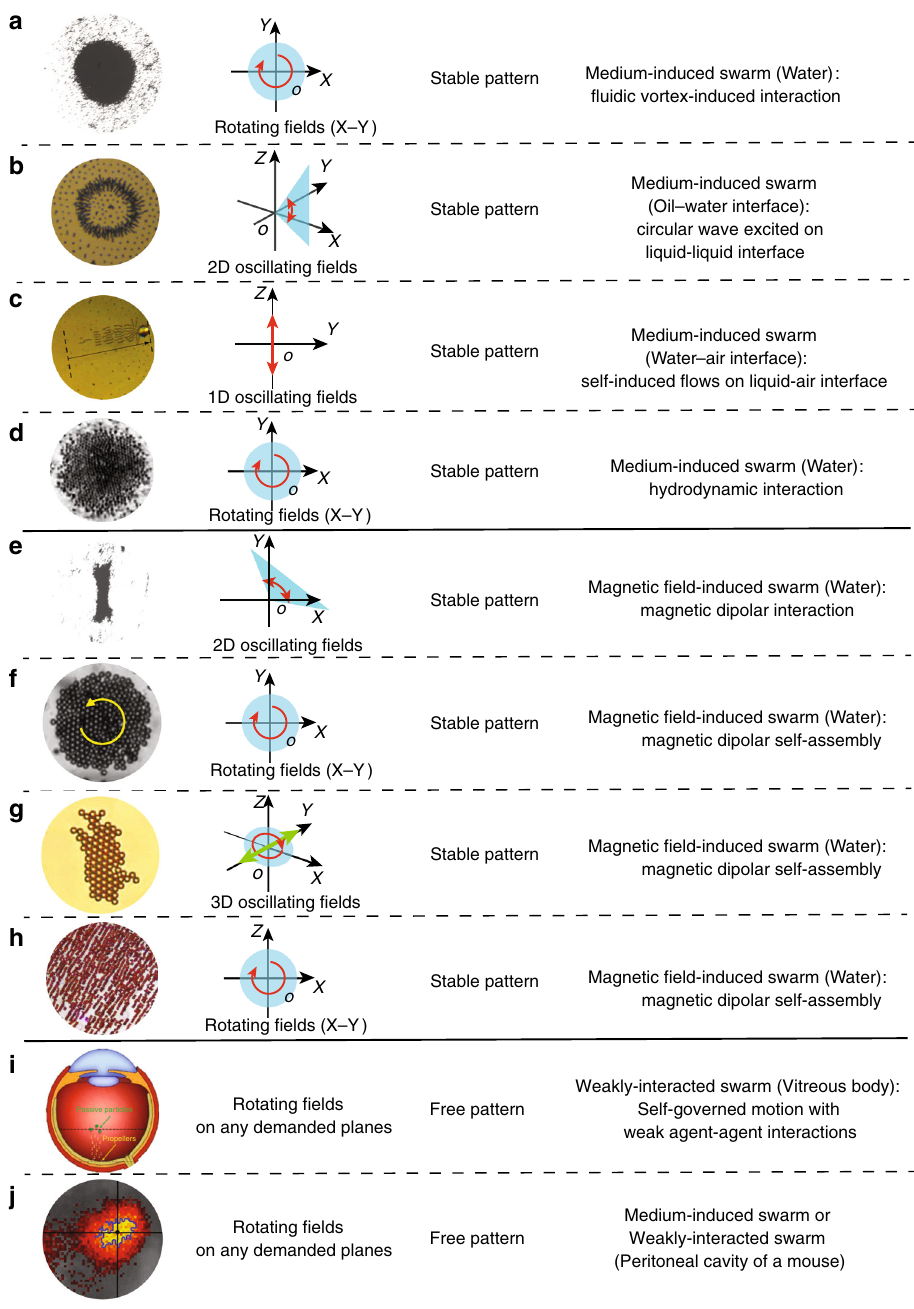
Fig. 1 A library of magnetic active swarms. a Paramagnetic nanoparticle vortex-like swarm can be generated using rotating magnetic fi elds, and the merging of fl uidic vortices is the main reason for the generation 20 . b Magnetic microparticles arrange into an aster on liquid – liquid interface, which is mainly due to the self-induced circular standing wave 19 . c A snake-like pattern is formed by magnetic microparticles on liquid – air interface actuated by an oscillating fi eld 28 . d A circular pattern formed by rotating helical swimmers 29 . e Paramagnetic nanoparticles form recon fi gurable ribbon-like swarms actuated by oscillating magnetic fi elds 21 . f By combining magnetic fi elds and ultrasound fi elds, superparamagnetic particles can assemble with each other due to dipole-dipole interaction under a rotating magnetic fi eld 30 . g Manipulation and propulsion of magnetic colloidal carpets realised by applying conical oscillating magnetic fi elds 31 . h Chain-like structure formed by rolling hematite colloids 32 . i Actuation of helical nano-swimmers in vitreous humour 33 . j A swarm of arti fi cial bacterial fl agella can be navigated in vivo, in the peritoneal cavity of a mouse by applying rotating magnetic fi elds 7 . The experimental planes of a – h are X – Y planes. For i , j the swimmers perform 3D locomotion, and the rotating plane of the magnetic fi eld changes with the desired moving